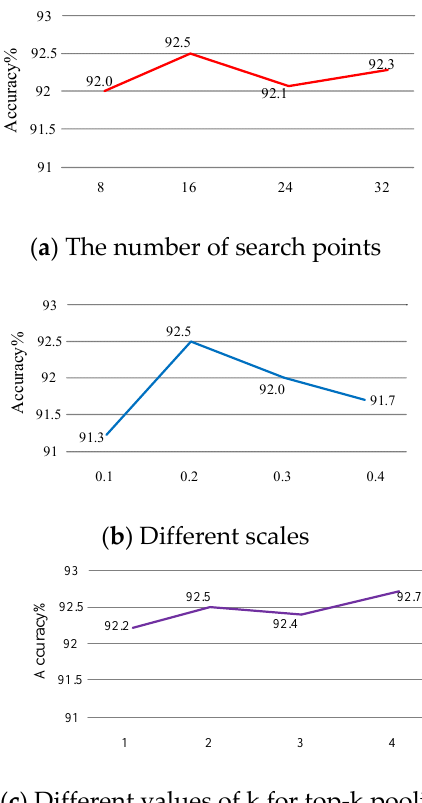
Figure 7. The comparison of key parameters in classification. Table 1. Classification accuracy of OECNN and other models on ModelNet40 [19].